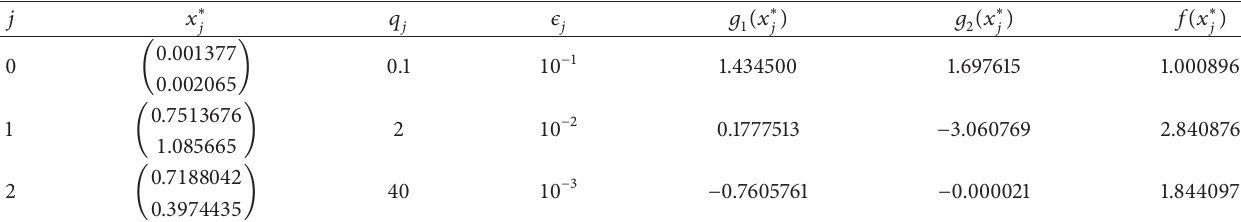
Table 3: Numerical results for Example 1 by Algorithm